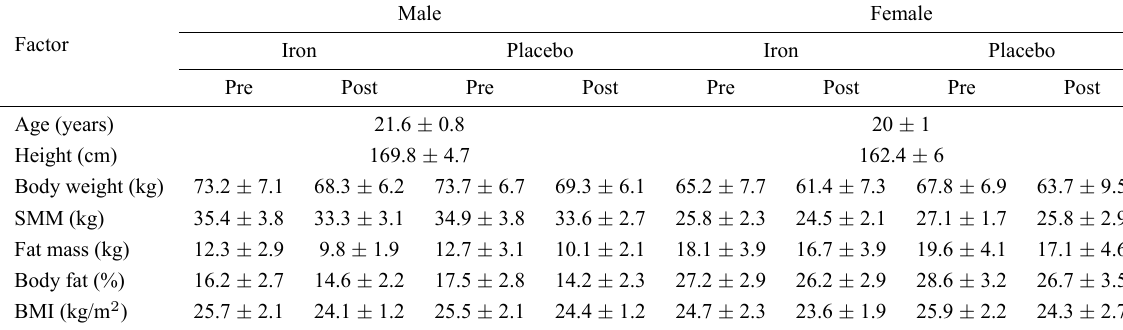
Table 2. Basic characteristics of